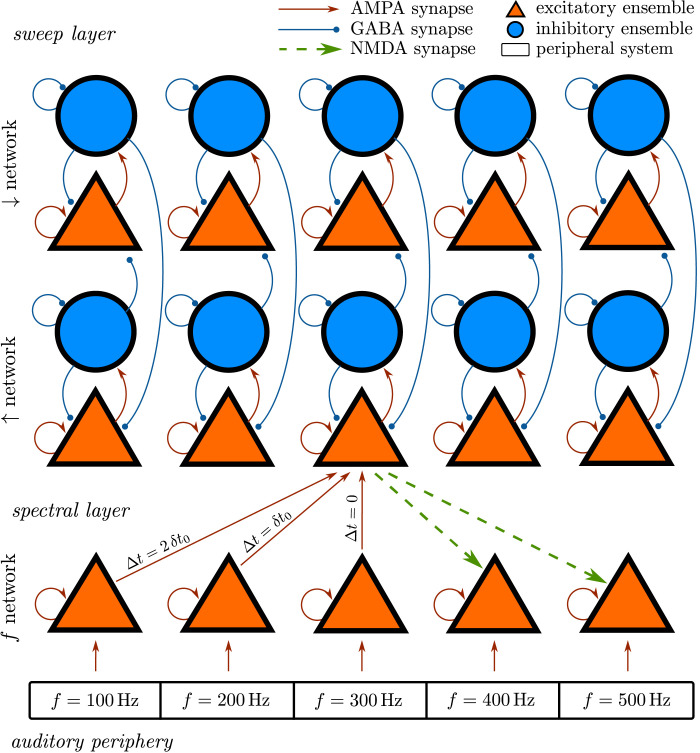
Diagram of the FM-feedback spectral model.The model consists of two levels: first, the spectral layer, with a network integrating the spectral information of the sound (f network); and second, the sweep layer, with one network specialised in detecting up (↑ network) sweeps and another network specialised in detecting down (↓ network) sweeps. The spectral layer integrates afferent inputs from the auditory periphery and encodes a representation of the stimulus that can be used to infer pitch. The sweep layer receives afferent inputs from the spectral layer that are used to decode the direction of the sweeps. Feedback connections from the sweep layer to the spectral layer modulate the time constants of the populations that are expected to be activated once the direction of the sweep has been decoded. The inhibitory ensembles in the up and down network enforce competition between up and down ensembles in a winner-take-all fashion. Note that the diagram is schematic and shows only 5 of the N = 100 populations and a single example of the connections between the sweep and the spectral layers. The labels of the boxes of the peripheral system are also schematic: the spectral resolution of the peripheral system is much higher. See Methods for specific details on the mathematical formulation of the model.